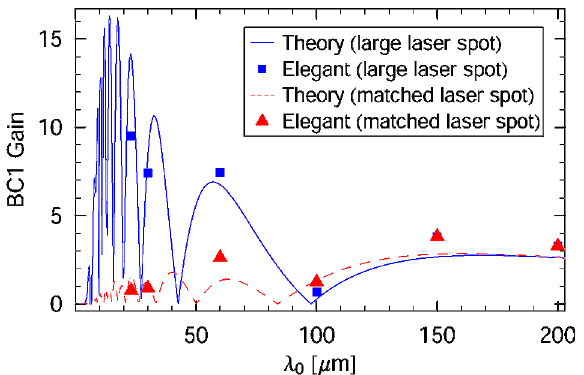
FIG. 11. (Color) Microbunching gain after BC2 as a function of the initial modulation wavelength (cid:5) for a laser heater with a 0 large laser spot (blue) and with a matched laser spot